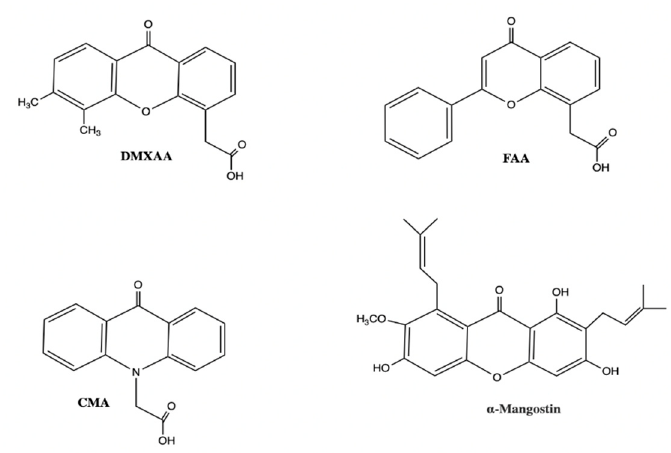
Figure 5. Small molecule STING agonists bearing structural similarity to DMXAA. Abbreviations: DMXAA, 5,6-dimethylxanthenone-4-acetic acid; FAA, flavone acetic acid;